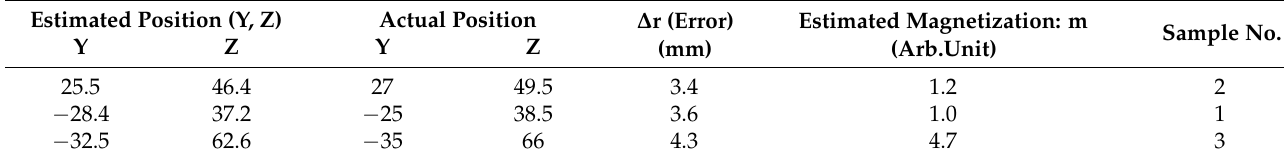
Table 2. Results of position and magnetization estimation (Third experiment).